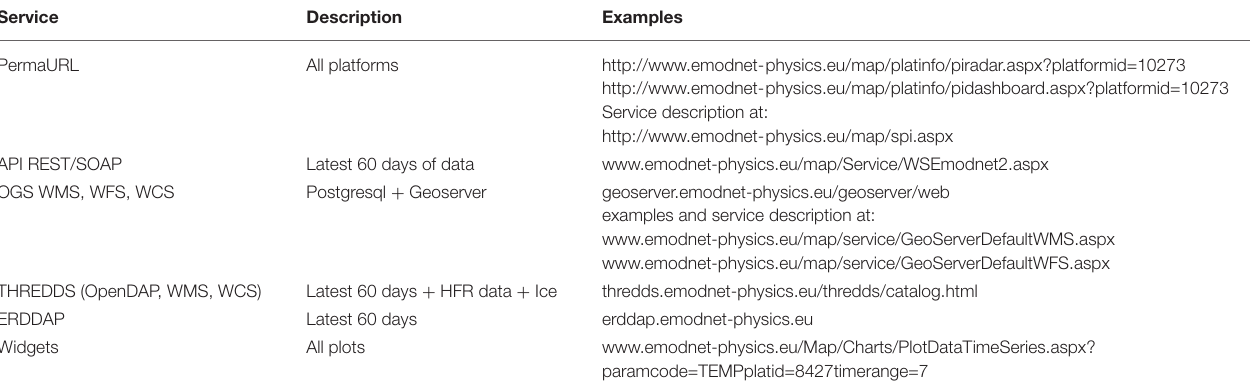
TABLE 4 | EMODnet physics interoperability machine to machine M2M